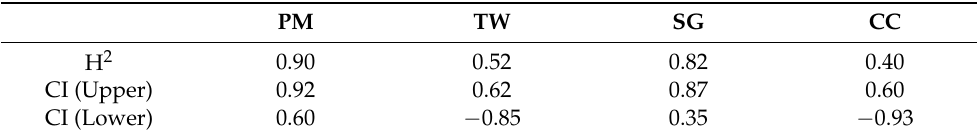
Table 11. Broad-sense heritability and confidence interval levels for agronomic and quality traits. PM TW SG CC H 2 0.90 0.52 0.82 0.40 CI (Upper) 0.92 0.62 0.87 0.60 CI (Lower) 0.60 − 0.85 0.35 −